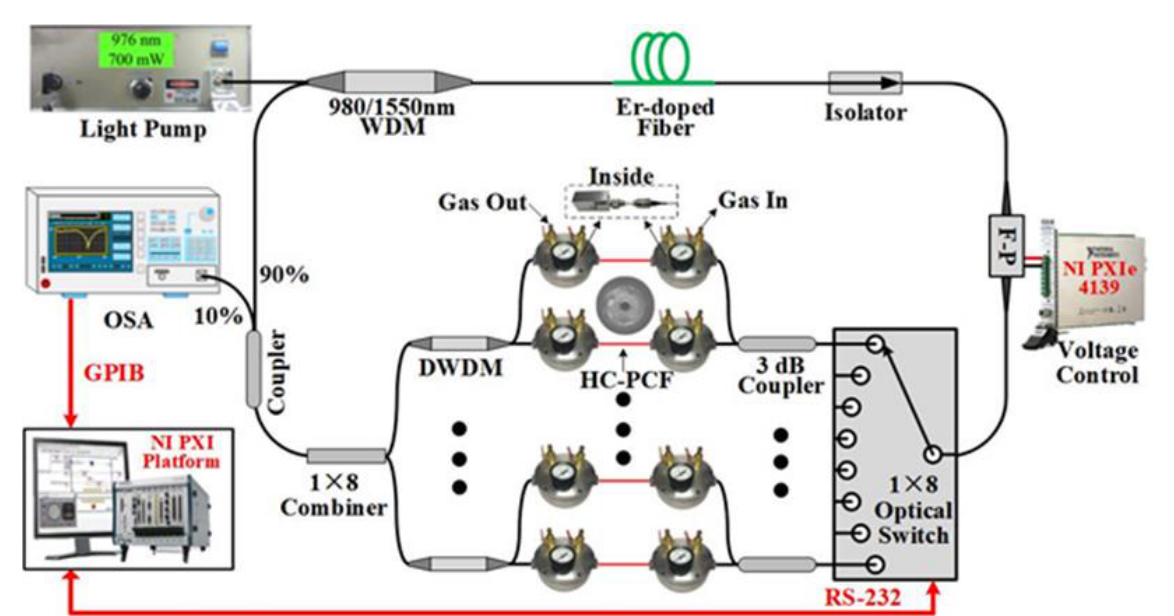
Figure 1. Experimental setup for the intracavity absorption gas sensor network.